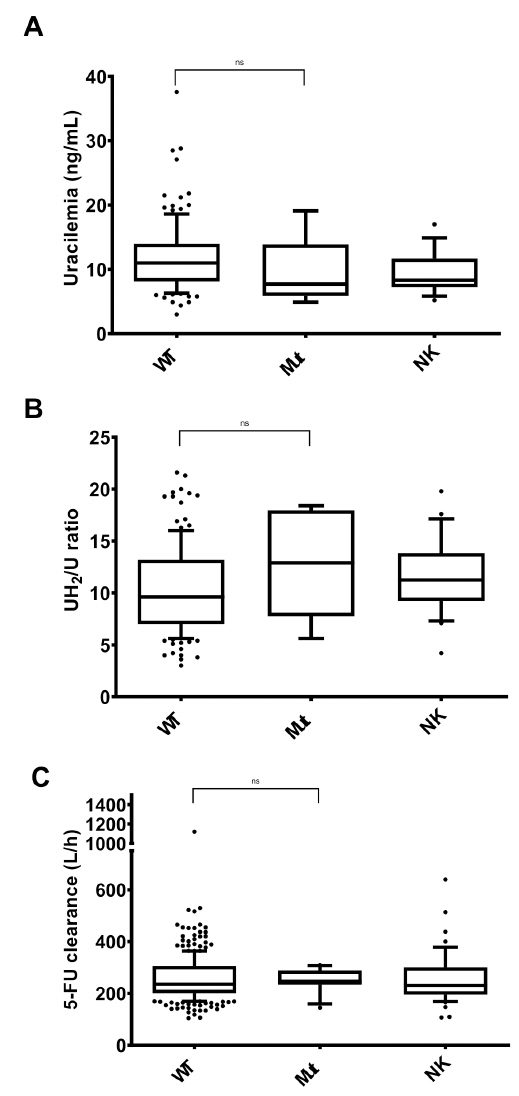
Figure 1. Distribution of uracilemia ( A ), UH 2 / U ratio ( B ), and 5-fluorouracil (5-FU) clearance ( C ) between patients DPYD wild-type (WT), heterozygous (Mut), or not known (NK). Limits of the boxplots are 10–90 percentiles. NK patients were not included in the statistical analysis. ns: non-significant. Table 2. Description of U, UH 2 / U, and 5-FU clearance distribution based on DPYD